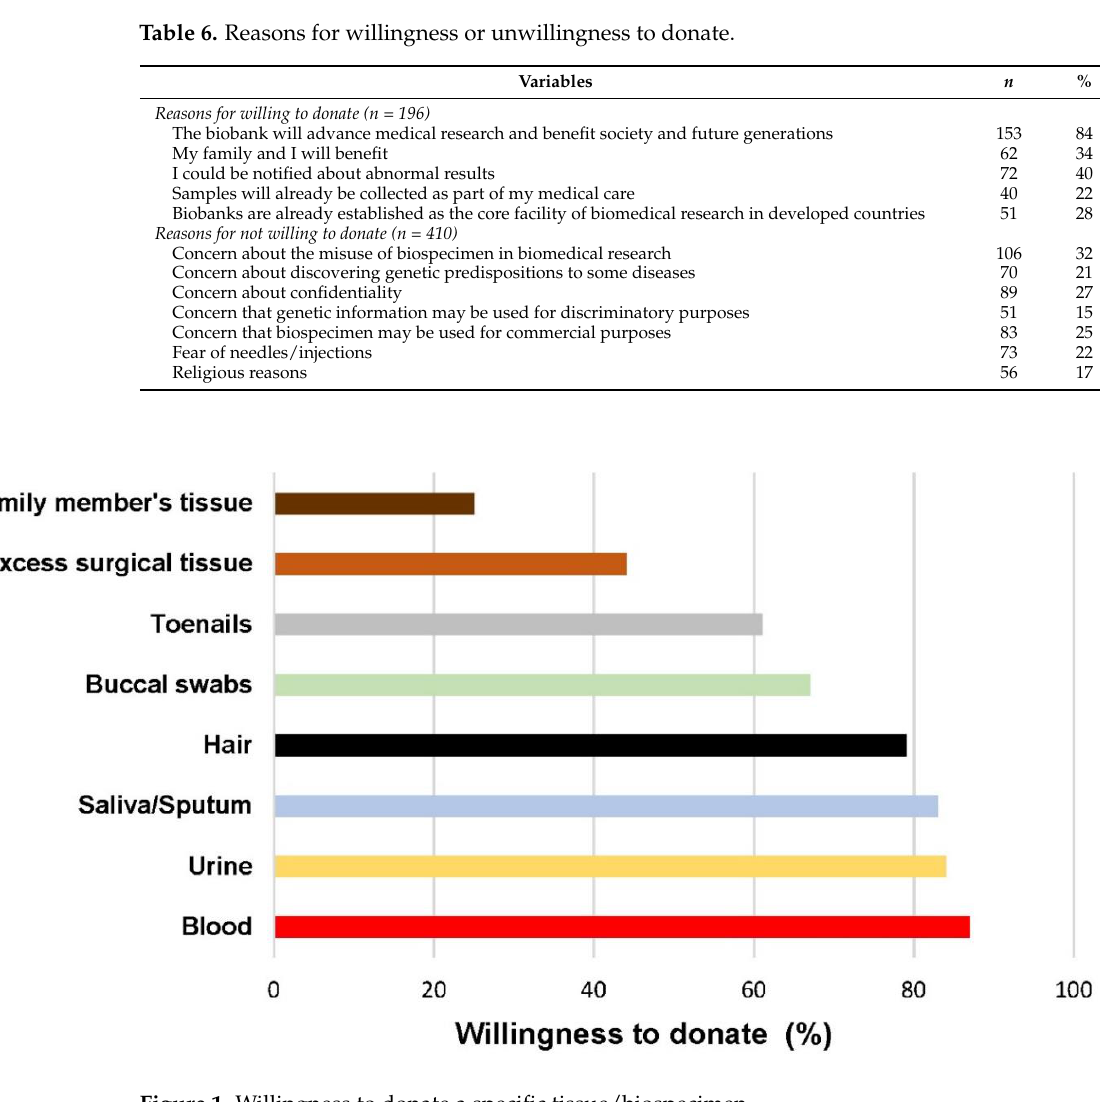
Figure 1. Willingness to donate a specific tissue/biospecimen.